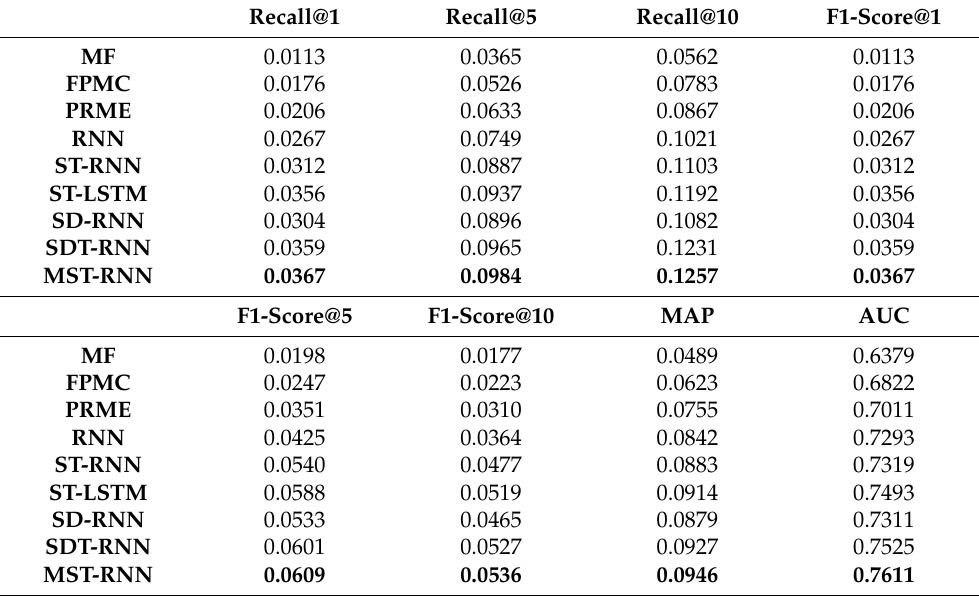
Table 1. Performance comparison evaluated by recall, F1-score, MAP, and AUC.